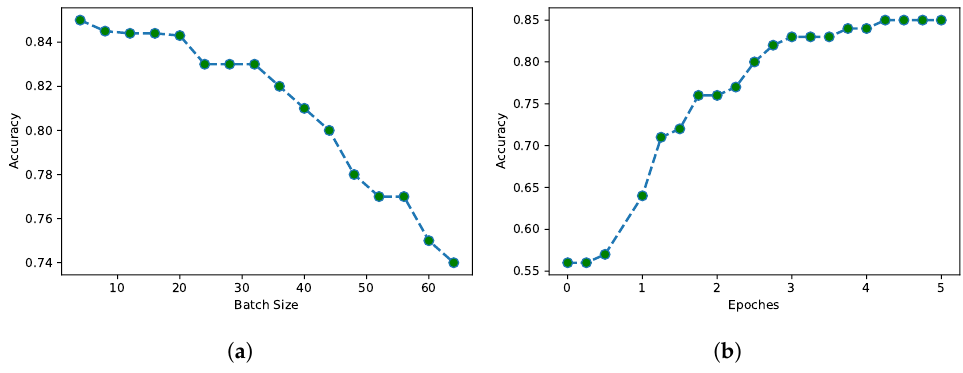
Figure 6. The impact on accuracy of the number of batches and epochs: ( a ) The impact of batch size on accuracy and ( b ) The impact of the number of epochs on accuracy.